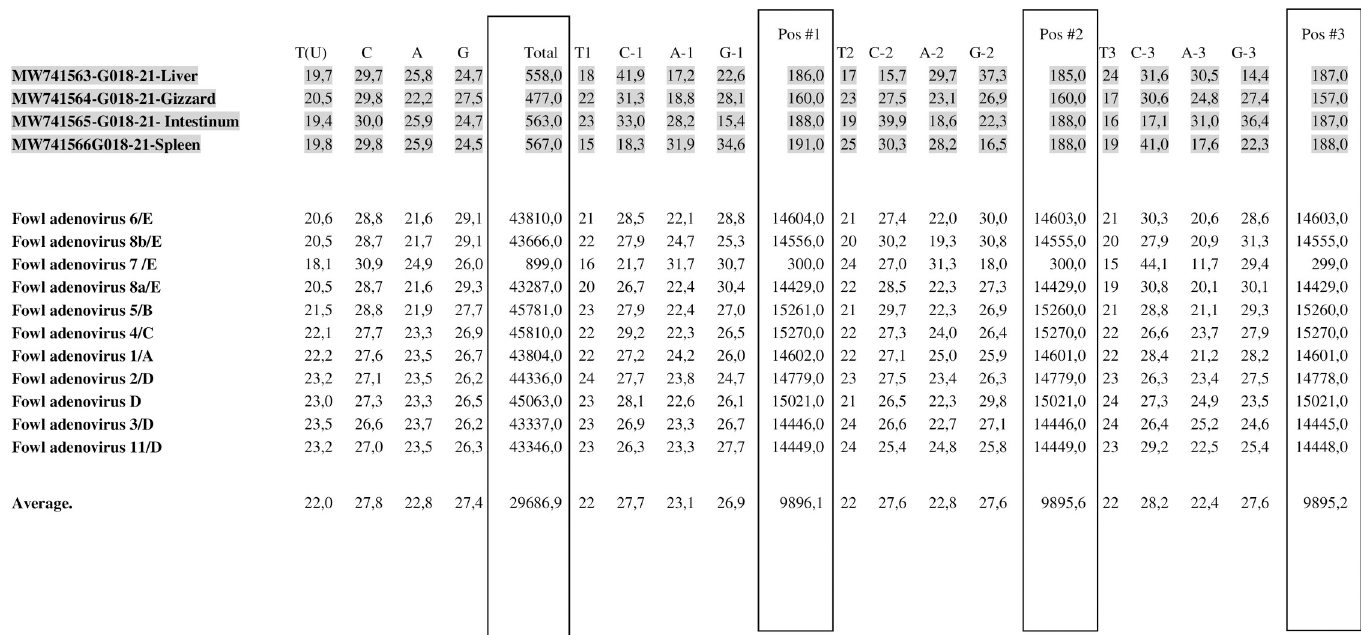
Fig 2. Analysis of codon composition of clinical strain sequences isolated from broiler chickens indicated in grey. Total number of nucleotides of examined strain sequences, number of nucleotides in the sequences tested in the first, second and third codon positions, respectively.